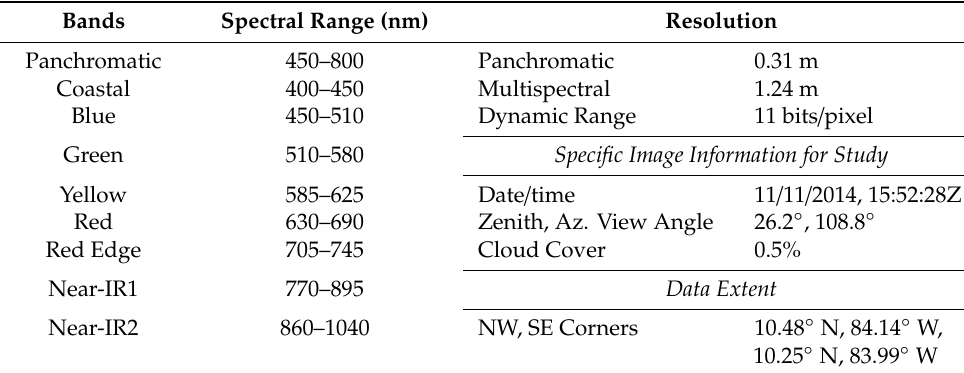
Table 1. WorldView-3 imagery specifications [43].